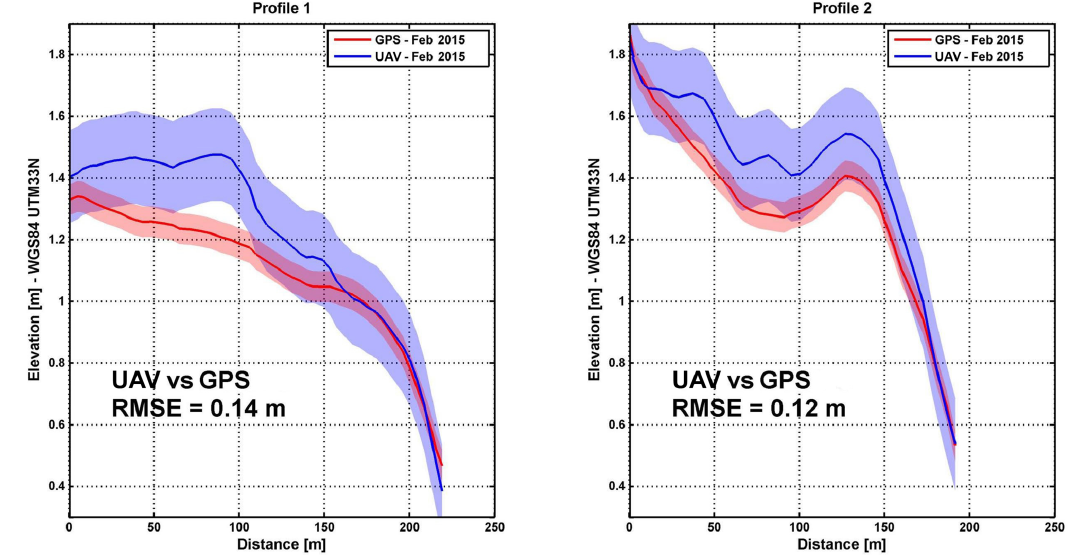
Figure 6. Comparisons between the February 2015 post-storm observed RTK GPS profile survey and post-storm UAV-derived DSM for profiles 1 and 2. The error bands are shown, defined a priori ( ± 15cm for UAV and ± 5cm for GPS) for visualization purposes. The RMSEs calculated a posteriori between the RTK GPS and UAV-derived data are